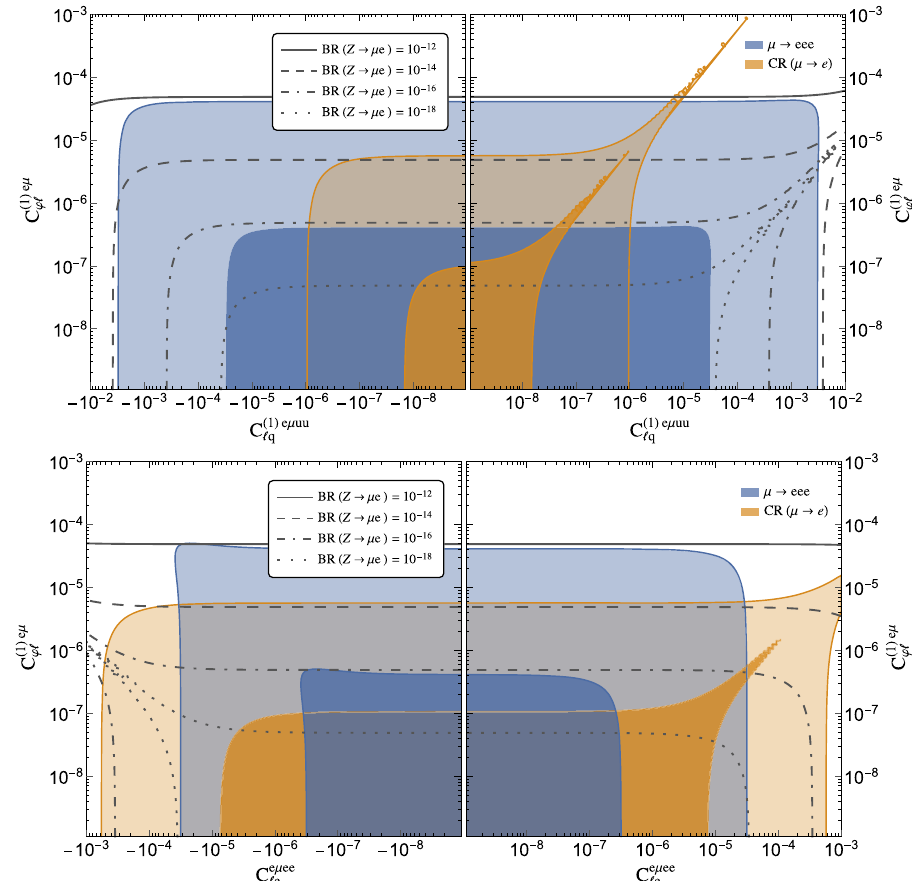
Fig. 3 Contours of BR( Z → μ e ) as a function of